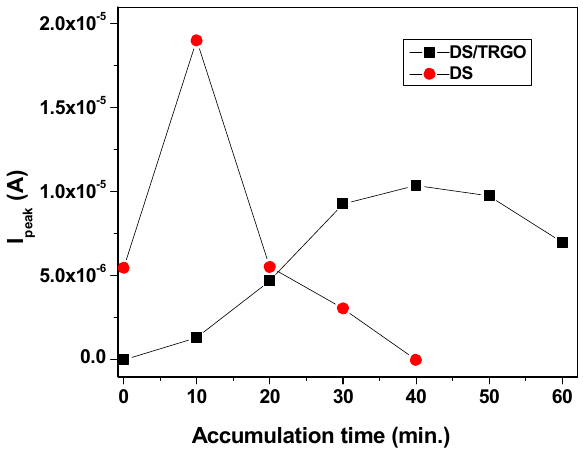
Figure 5. I peak versus accumulation time of CA199-His at bare DS (red) and DS / TRGO modified electrode (black) in the presence of 0.07 mg / mL CA199-His (pH 7.6 PBS supporting electrolyte) .